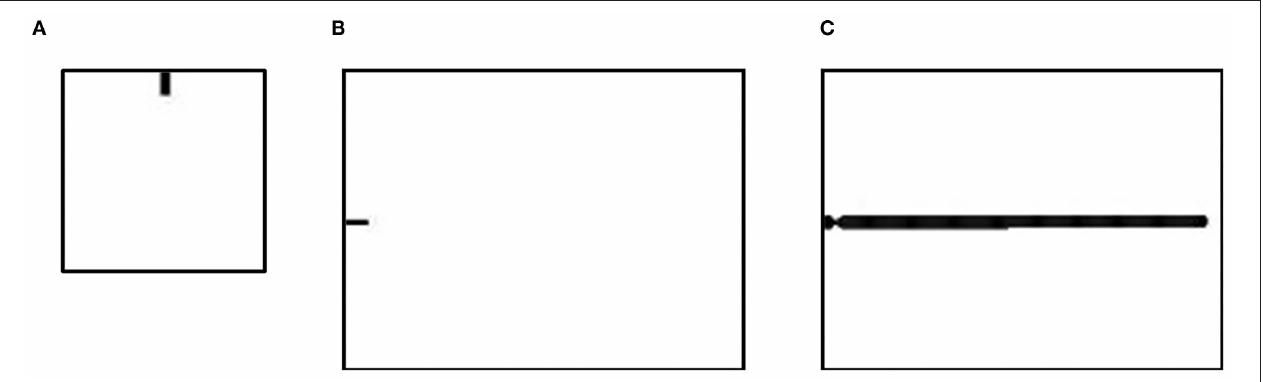
FIGURE 2 | The original state of the spine simulation and the dendrite simulation. (A) The original state of the spine simulation is used to simulate a single spine in different conditions. Simulations were performed on a 100 × 100 grid. The grid size of space is 0.3. Fixed parameters in Equation (2): c = 0.002, µ = 0.16, υ = 0.04, ρ A = 0.01, ρ H = 0.00005, c 0 = 0.02, γ = 0.02, D A = 0.02, D H = 0.26, D S = 0.06, d = 0.0035, e = 0.1, and f = 10. (B) The first step in the dendrite simulation is used to simulate the dendrite trunk. Simulations were performed on a 150 × 200 grid. The grid size of the space is 0.3. Parameters in Equation (2): c = 0.002, µ = 0.16, υ = 0.04, ρ A = 0.03, ρ H = 0.0001, δ A = 0, δ H = 0, c 0 = 0.02, ε = 0.017, γ = 0.02, D A = 0.02, D H = 0.26, D S = 0.06, d = 0.0035, e = 0.1, and f = 10. (C) The second step in the dendrite simulation grows from (A) and is used to simulate spines in different conditions. Fixed parameters in Equation (2): c = 0.002, µ = 0.16, υ = 0.04, ρ A = 0.02, ρ H = 0.00005, c 0 = 0.05, γ = 0.02, D A = 0.02, D H = 0.26, D S = 0.06, d = 0.0035, e = 0.1, and f = 10. In (A,B) , black regions ( A = 2, H = 0.02, S = 1, Y = 1) represent a part of a neuron, and white regions ( A = 0.001, H = 0.001, S = 1, Y = 0) represent the environment surrounding the